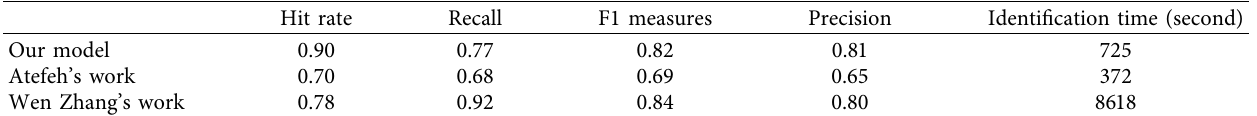
Table 2: Performance comparison results of the fake reviews.